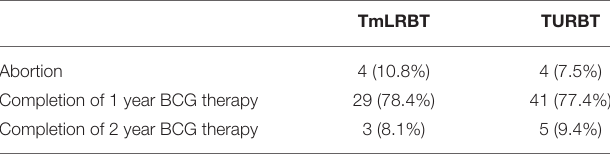
TABLE 4 | Summary of the BCG therapy